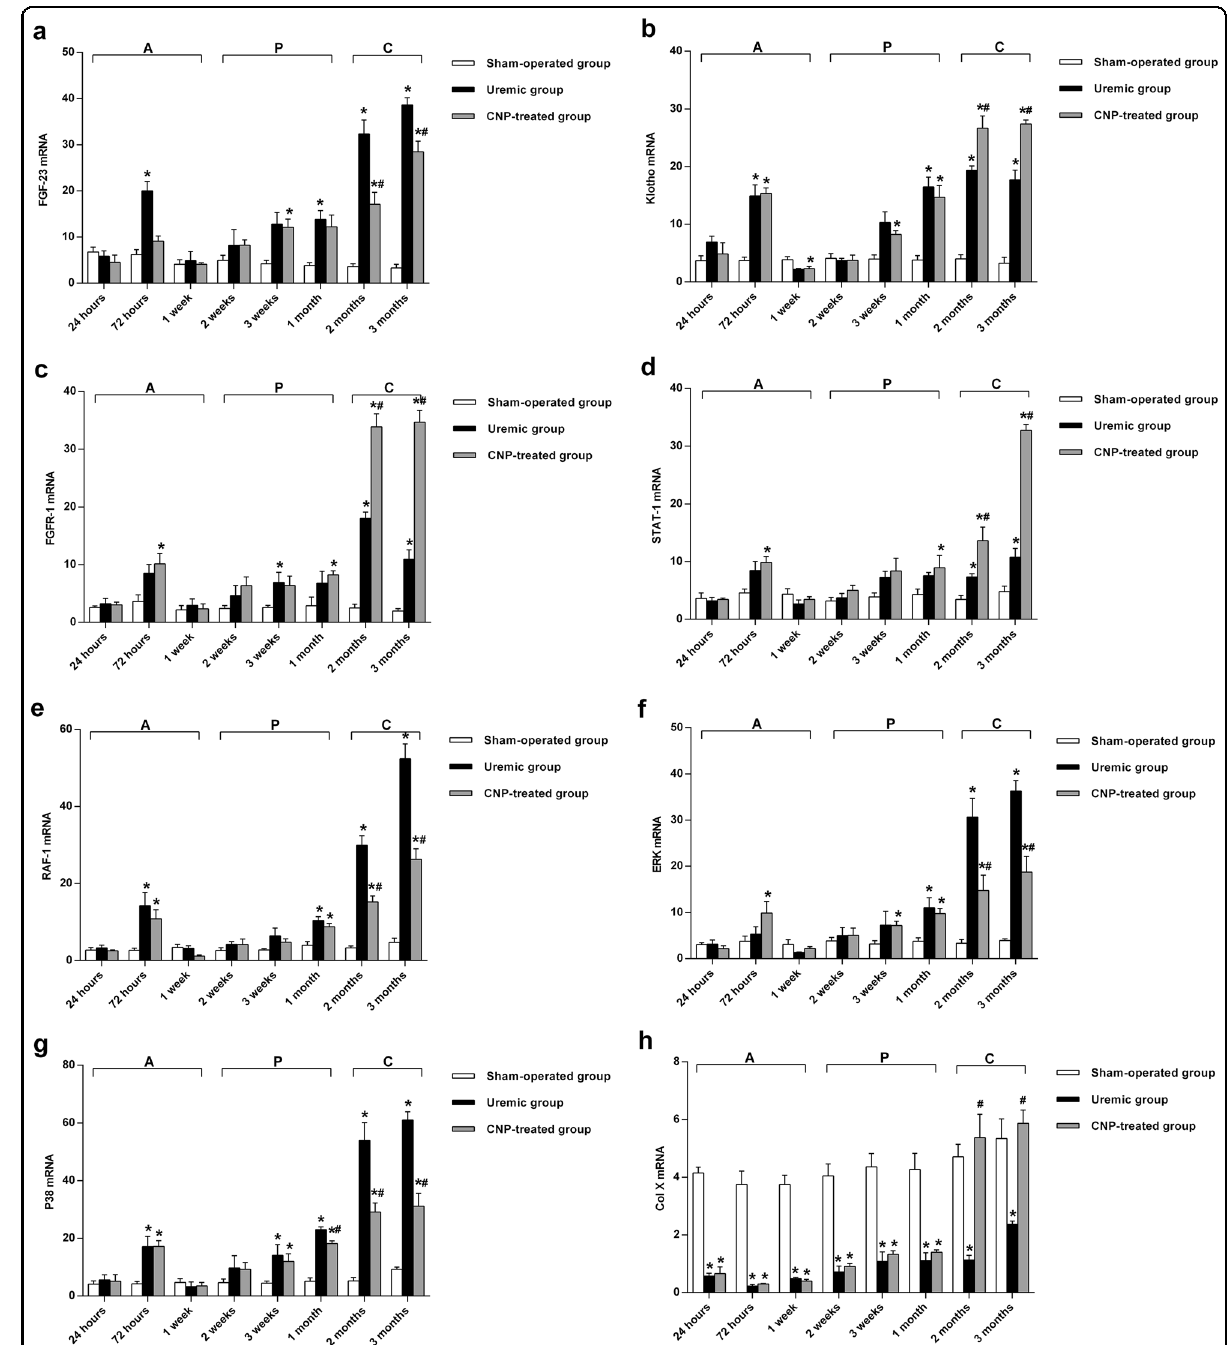
Fig. 6 Real-time PCR analysis of bone FGF-23, Klotho, FGFR-1, STAT-1, RAF-1, ERK, P38, Col X, and GAPDH mRNA expression in sham- operated, uremic, and CNP-treated rats. Uremic group vs. sham-operated group: The uremic group had signi fi cant elevations in FGF-23, Klotho, RAF-1, and P38 mRNA expression in each stage ( a , b , e , g ); upregulations of FGFR-1 and ERK mRNA in the progressive stage and chronic stage ( c , f ); and overexpression of STAT-1 mRNA only in the chronic stage ( d ). CNP-treated group vs. uremic group: FGF-23 transcripts were signi fi cantly inhibited by exogenous CNP in the chronic stage ( a ); Klotho, FGFR-1, STAT-1, and Col X mRNA expression in the CNP-treated group was signi fi cantly higher in the chronic stage ( b – d , h ); CNP treatment initiated a dramatic suppression of P38, RAF-1, and ERK transcripts after 1, 2, and 2 months, respectively ( e – g ). CNP-treated group vs. sham-operated group: In comparison with the sham-operated group, Klotho, ERK, and P38 mRNA levels in the CNP- treated group signi fi cantly increased in every stage ( b , f , g ); FGF-23, FGFR-1, and RAF-1 mRNA were signi fi cantly elevated in the progressive stage and chronic stage ( a , c , e ); STAT-1 mRNA signi fi cantly increased in the chronic stage ( d ); Col X mRNA signi fi cantly decreased by 2 months postoperatively ( h ). * P < 0.05, signi fi cantly different from the corresponding sham-operated group; # P < 0.05, signi fi cantly different from the corresponding uremic group. A acute stage, P progressive stage, and C chronic